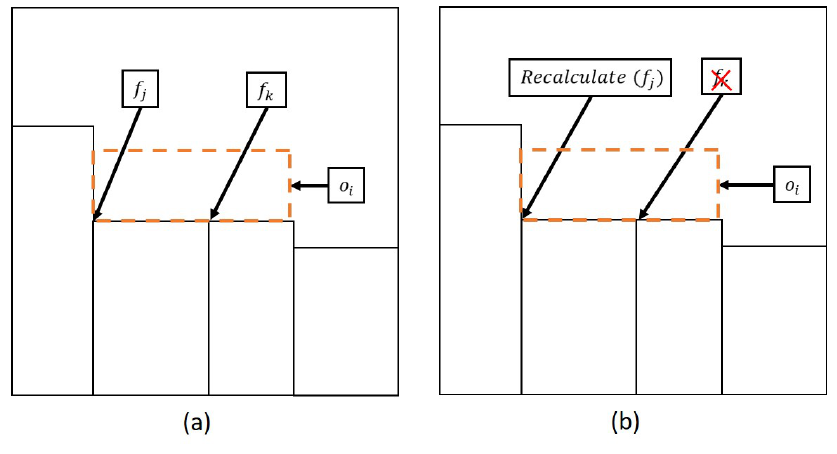
Figure 4. ( a ) Shows the overlap between an object and a flag. ( b ) The overlap fix.